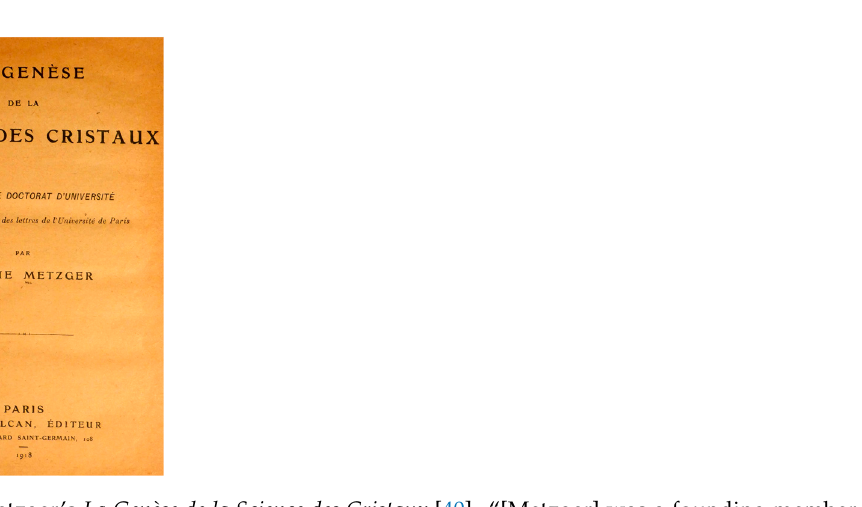
Figure 9. Metzger’s La Genèse de la Science des Cristaux [40]. “[Metzger] was a founding member and officer of the Académie Internationale d’Histoire des Sciences but was never able to obtain a proper academic position, presumably meeting the impasse that was her gender, codified by the credentials that she was unable to acquire [41]. Metzger, the first woman to make a lasting mark on the developing profession of the history of science, has since become celebrated as a courageous figure for her resounding refusal to accommodate herself to patronizing colleagues [42].